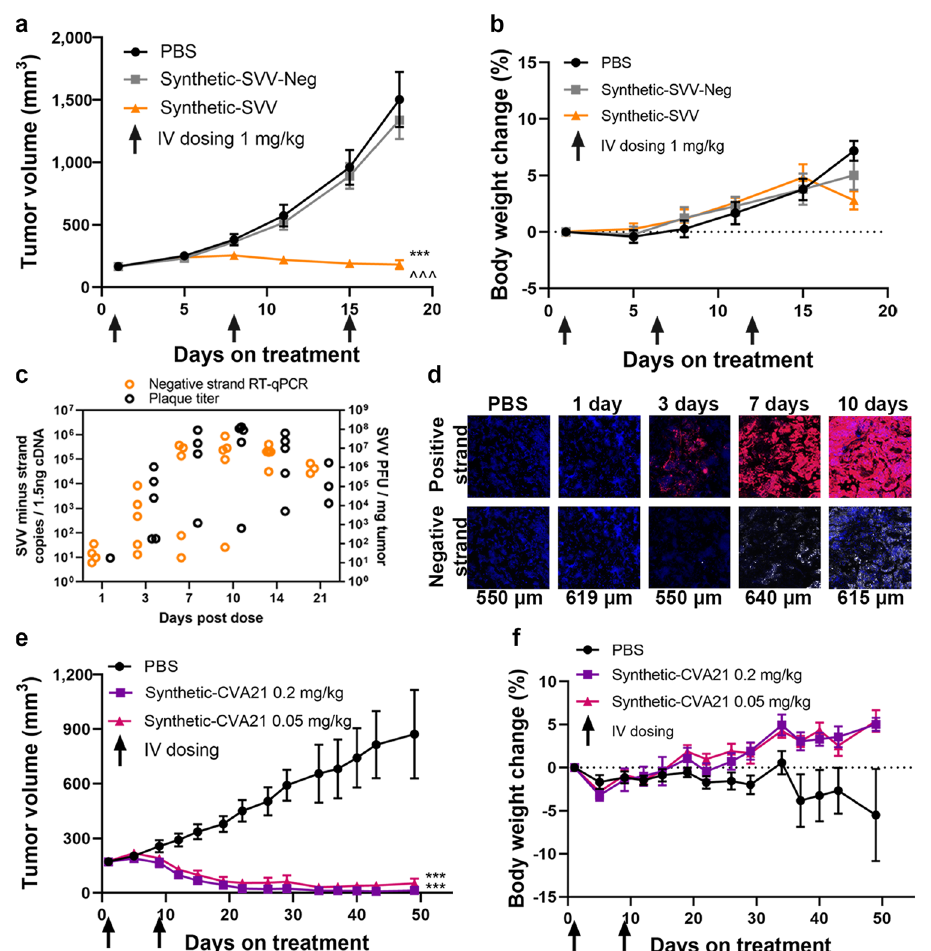
Fig. 2 | Intravenous Synthetic RNA virus administration demonstrates viral replication in tumors and mediates tumor regression. a – d Athymic nude mice implanted subcutaneously with NCI-H446 SCLC xenograft tumors. a , b Mice were treated via IV administration with either vehicle control (PBS), Synthetic-SVV-Neg, or Synthetic-SVV on Days 1, 8, and 15, at 1.0 mg/kg ( n =8 per group). a Tumor volume (mm 3 ) and b body weight changes (%) were monitored. Tumor growth (mm 3 ) and body weight changes (%) were monitored. Data are reported as mean ± s.e.m. Statistical signi fi cance was determined using a mixed linear model *** p <0.001 vs. PBS and ^^^ p <0.001 vs. Synthetic-SVV-Neg. c , d Replication of Synthetic-SVV in NCI-H446 tumors after a single IV dose of 0.1 mg/kg SVV. c SVV negative-strand RNA levels were determined using RT-qPCR ( n =5 per time point). SVVinfectionsparticles(PFU)weredeterminedbyplaqueassay. n =3independent